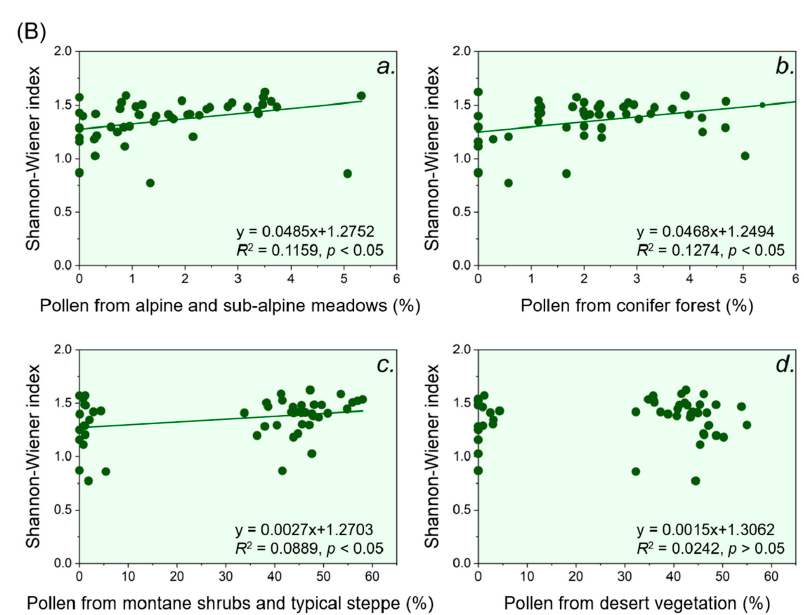
Figure 4. Linear relationships between the observed pollen percentage from different vegetation belts and the Shannon-Wiener index. Notably, the horizontal axis represents the sum of the percentage of pollen taxa derived from different vegetation belts (from a to d) observed in the sedimentary sites (specific taxa contained in each vegetation belt are listed in Table 1). Panel ( A ) represents Sayram Lake, and panel ( B ) represents Aibi Lake. During the warm and dry periods of the early Holocene, from 12,000 to 8000 years before present (yr BP) (Figure 5a,b), the conifer forest belt moved up, and the belts of alpine and sub- alpine meadows and typical steppe moved up as well (Figure 6a), because the observed pollen taxa diversity indicated by the Shannon-Wiener index around Sayram Lake was very high, reaching a mean of 1.56 (Figure 5c), which was close to the diversity index (1.65) of the lower boundary of the modern forest belt (Table 2). Moreover, the observed pollen taxa diversity indicated by the Simpson index around Sayram Lake was also very high, reaching a mean of 0.69 (Figure 5d), which was close to the diversity index (0.70) of the lower boundary of the modern forest belt (Table 2). Therefore, we infer that Sayram Lake was probably at the lower boundary of the conifer forest during the early Holocene, thus the forest-steppe ecotone moved upward accordingly, and was close to Sayram Lake.